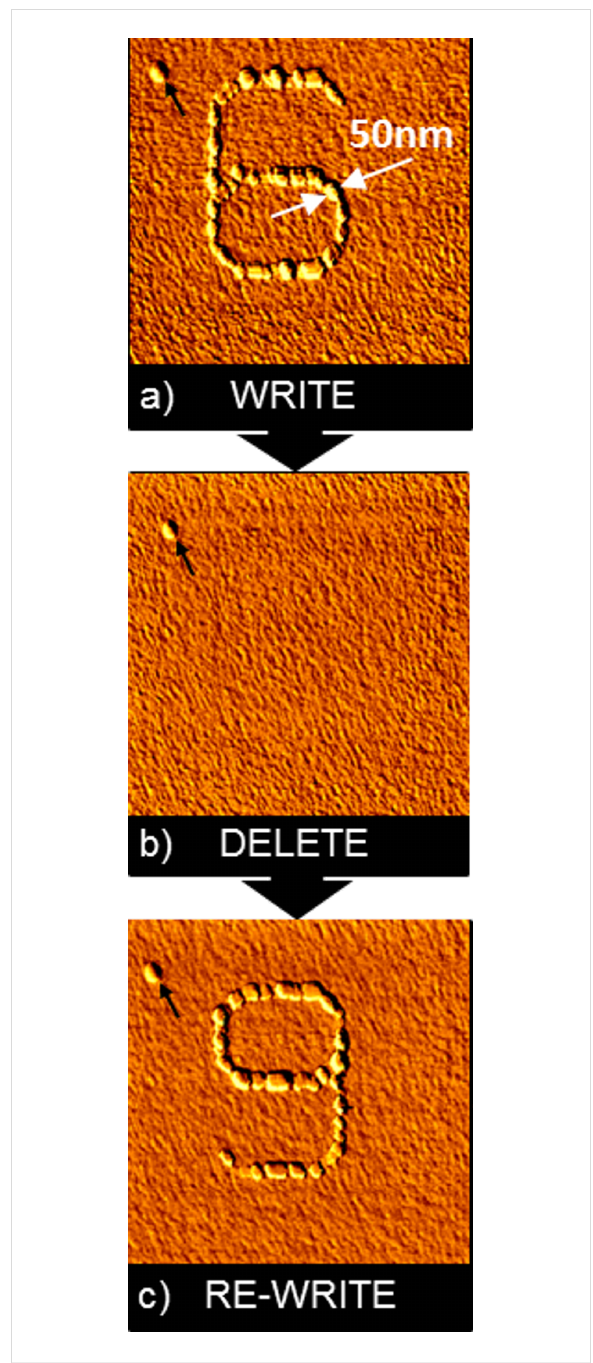
Figure 2: Reversible mechano-electrochemical writing of Cu nano- structures. (a) WRITE: In situ AFM image of an initial Cu island struc- ture (“6”). The “6”-structure was deposited by tip-induced mechano- electrochemical writing on a gold substrate, applying a deposition potential of − 60 mV versus Cu/Cu 2+ for 5 s. (b) DELETE: In situ AFM image of the gold substrate after deletion. For deletion a potential of +0.2 mV versus Cu/Cu 2+ was applied for 180 s. (c) RE-WRITE: In situ AFM image of a further Cu island structure (“9”). The “9”-structure was deposited on the same area where previously the “6”-structure had been written and deleted. For orientation see the point-shaped defect in the upper-left corner of the images, marked by an arrow. Typical height of the islands: 15 nm. Scan size: 1.6 µm × 1.6